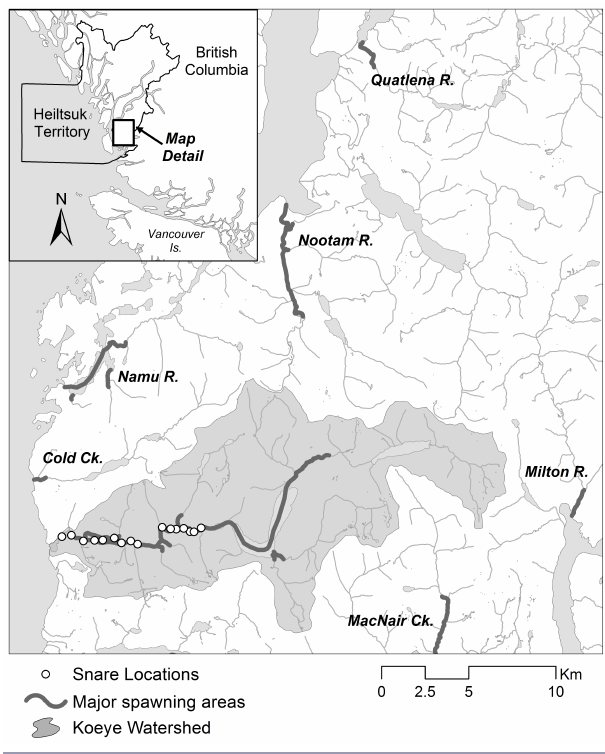
Fig. 1 . Study area and major spawning areas in the Koeye River, Heiltsuk Territory (British Columbia, Canada) and surrounding